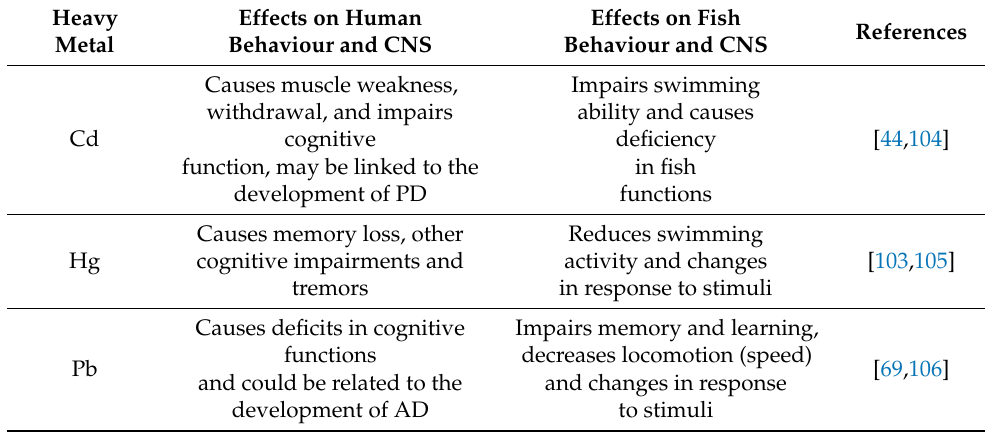
Table 1. Comparison between the heavy metals’ effects on human and fish behaviour and